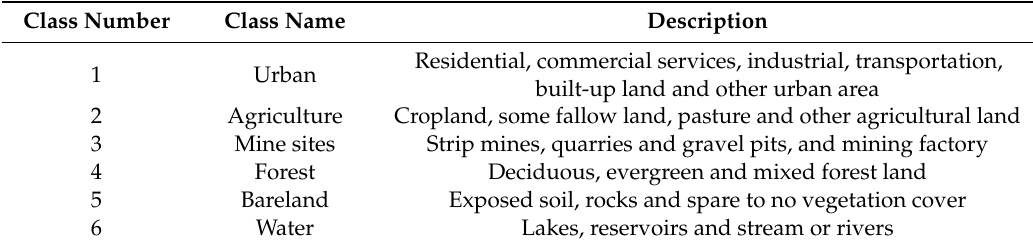
Table 2. Land cover classification